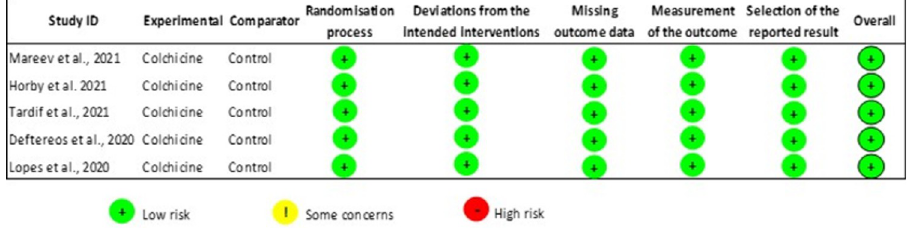
Fig 8. Quality assessment of RCTs using revised cochrane risk-of-bias